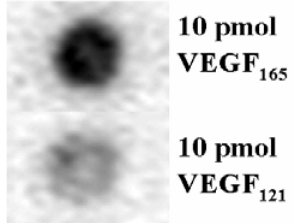
Figure 1. Evaluation of aptamer binding against the VEGF family. Ten pmol of each of VEGF and VEGF were immobilized on a nitrocellulose membrane. The membrane 121 165 was incubated sequentially with 100 nM of FITC-modified Vap7 and with HRP-labeled anti-FITC antibody. Finally, the chemiluminescence generated by HRP was detected to investigate the binding between Vap7 and the proteins. The black spots represent Vap7 bound to the